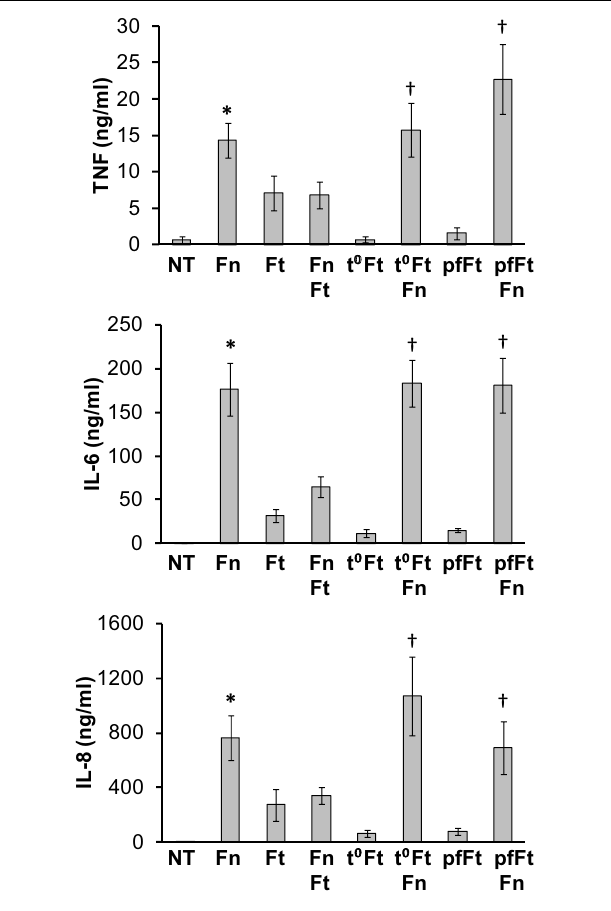
FIGURE 5 | F. tularensis suppression is observed during early infection time points. Primary human monocytes were infected at for 1, 4, 18, or 24h with F. novicida (Fn), F. tularensis (Ft) or both at an MOI of 50 for each bacteria. Cell-free supernatants were collected and assayed using sandwich ELISAs for TNF- α , IL-6, and IL-8. Graphs represent the mean ± s.e.m. from 4 independent donors. Data were analyzed by ANOVA. ∗ p < 0 . 05 (Fn vs. Ft and Fn +